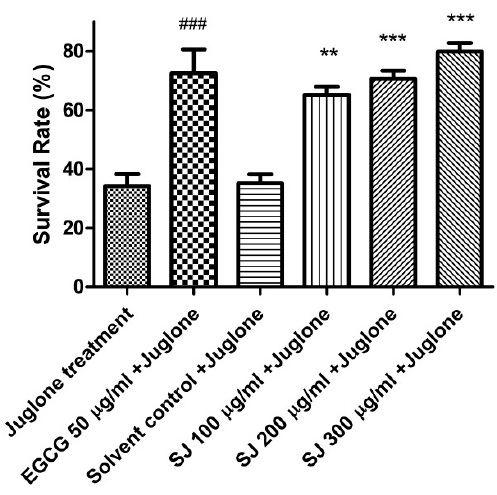
Figure 2. Effect of SJ extract on the survival rate of N2 worms pretreated with different doses of the extract and then subjected to oxidative stress via a toxic dose of juglone. SJ 300 µg/mL + juglone group showed a highly significant increase in rate of survival compared with solvent control + juglone group. Data is represented as mean ± SEM of survival rate % ( n = 5) obtained by one-way analysis of variance test (ANOVA) followed by Bonferroni’s method of correction. ** p < 0.01 and *** p < 0.001 in comparison with solvent control + juglone group. ### p < 0.001 in comparison with juglone group.